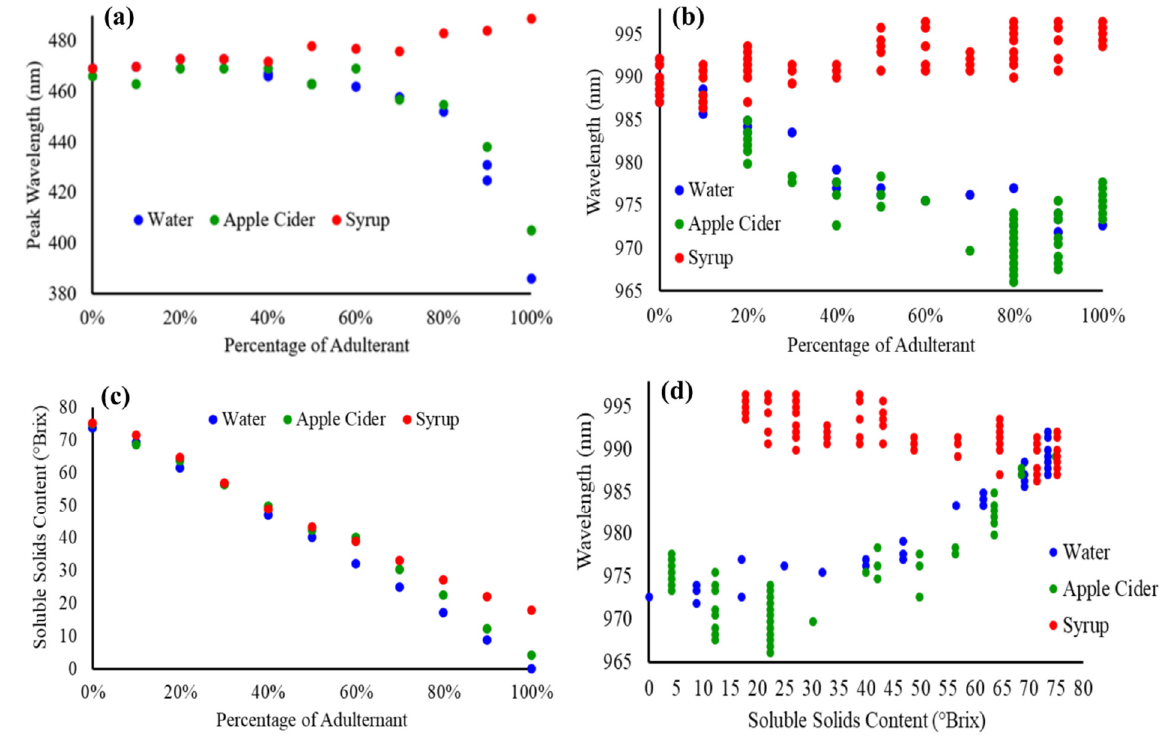
Figure 5. ( a ) Visible and ( b ) near-infrared peak absorbance of the samples against the percentage of added adulterant, ( c ) relationship between soluble solids content (in o Brix) and the percentage of added adulterant, and ( d ) absorbance at near-infrared peak and the soluble solids content of the samples.